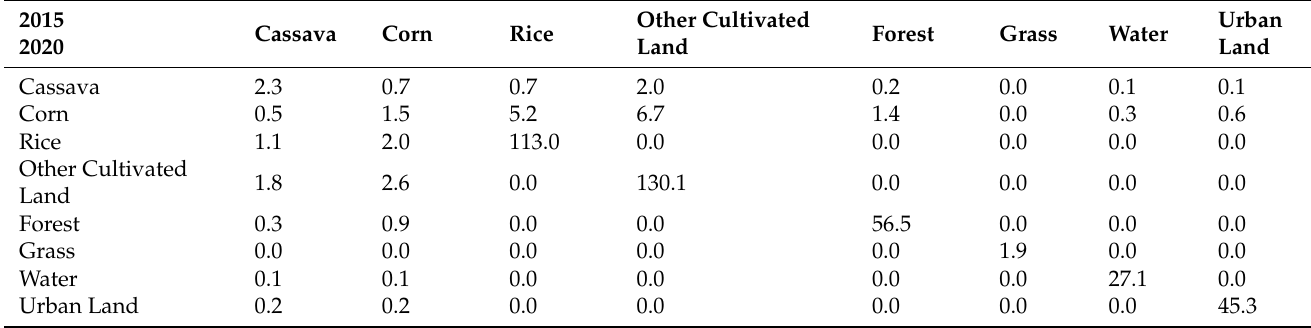
Table 3. Land-use transfer matrix of the Yujiang River Basin (km 2